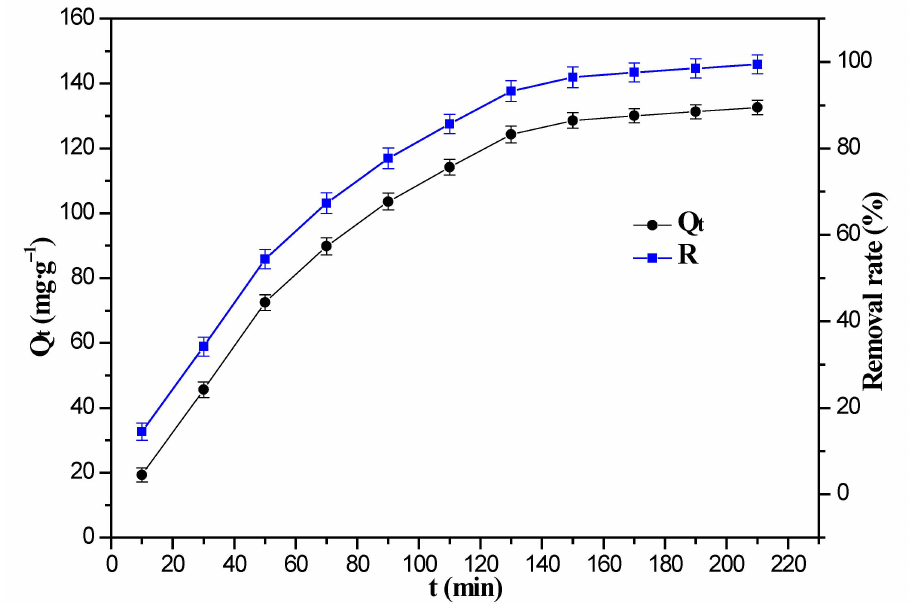
Figure 11. Effect of adsorption time on the uptake of Cr(VI) ions. Adsorption conditions: the initial Cr(VI) ions’ concentration, 80 mg · L − 1 ; volume, 50 mL; pH, 2.0; adsorbent dosage, 0.03 g; temperature, 298